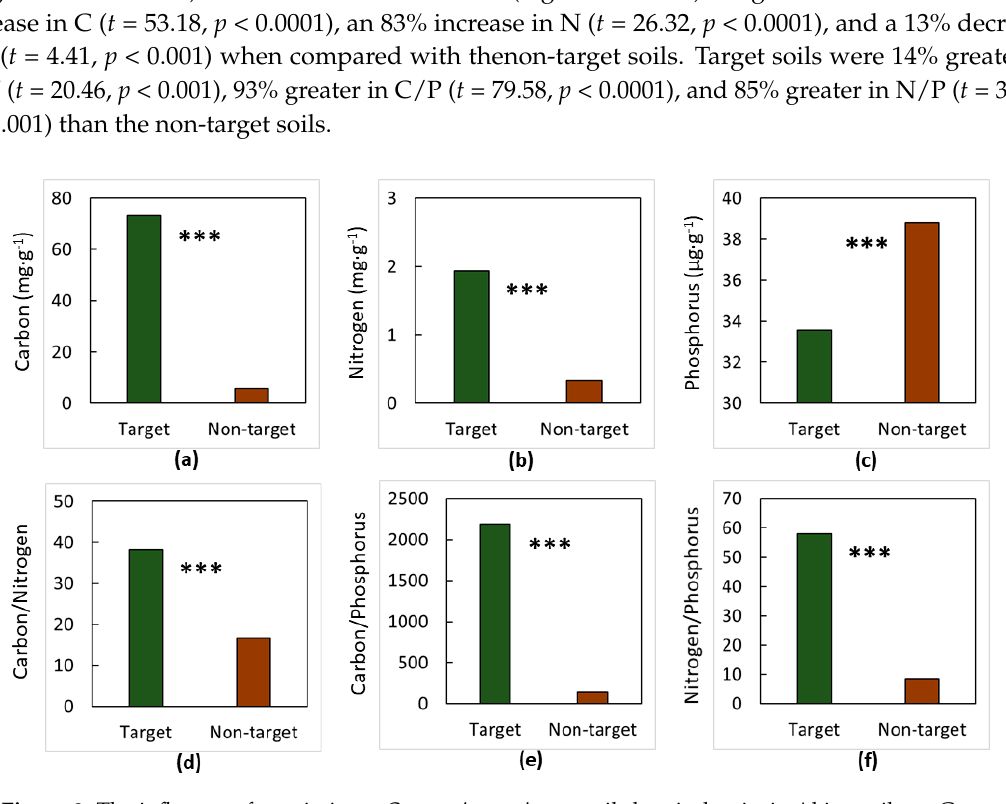
Figure 3. The influence of proximity to Cycas micronesica on soil chemical traits in Akina soils on Guam. Target soils were collected underneath cycad trees. Non-target soils were collected 5-m from focal cycad trees. ( a ) Total carbon; ( b ) Total nitrogen; ( c ) Modified Truog phosphorus; ( d ) Carbon/nitrogen; ( e ) Carbon/phosphorus; and, ( f ) Nitrogen/phosphorus. *** = significant at 0.001.